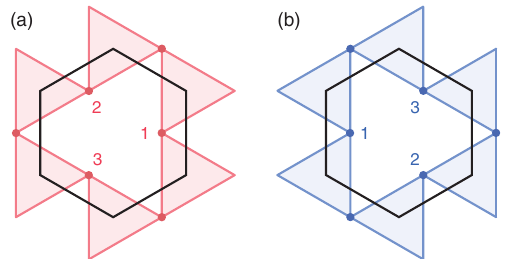
FIG. 7. Simplified Fermi surface to show Fermi surface nesting with different wave vectors. (a),(b) Fermi surfaces for different valley degrees of freedom. Labels 1, 2, and 3 are the patch indices, assigned at the hot